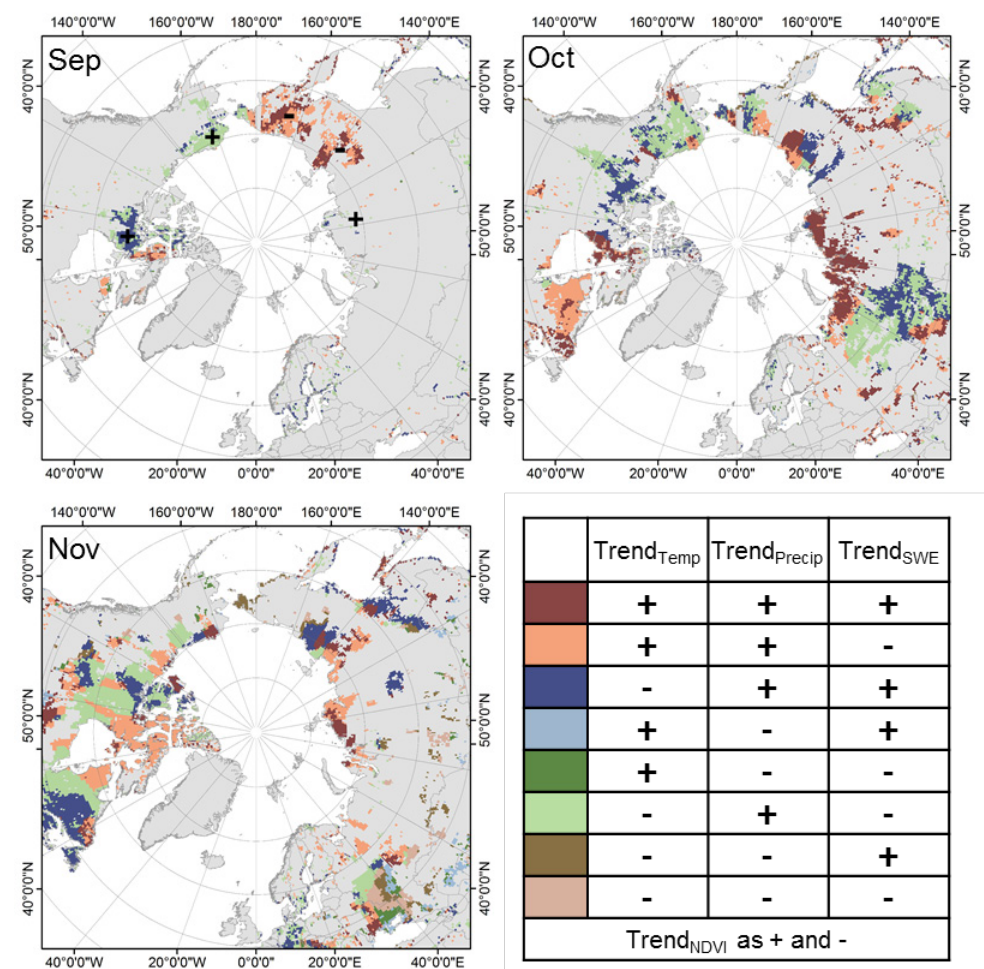
Figure 4. Co-occurrence of different climatic and ecosystem trends on pan-arctic scale between 1981 and 2012 (September to November) (for more explanation see Figure